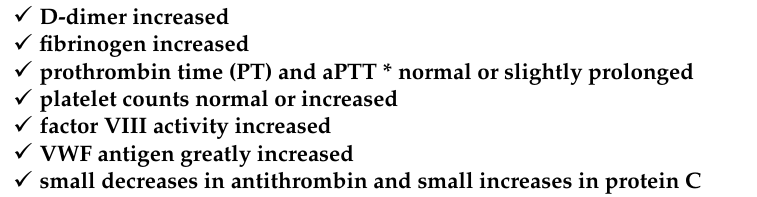
Table 2. The hypercoagulable state and predominant coagulation abnormalities in patients with covid-19 [Panigada M, Bottino N, Tagliabue P, et al. Hypercoagulability of COVID-19 patients in Intensive Care Unit. A Report of Thromboelastography Findings and other Parameters of Hemostasis. J Thromb Haemost 2020].